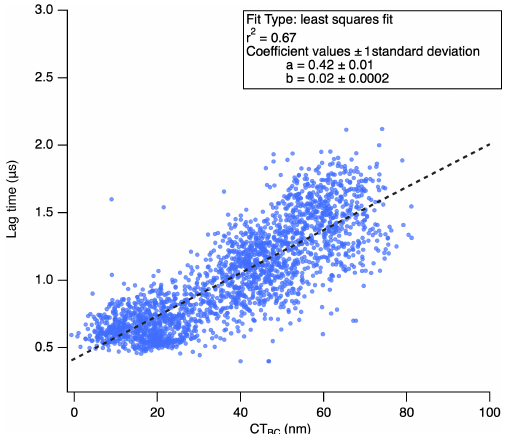
Figure 9. Scatterplot as a function of lag time (i.e., delay time) and BC coating thickness (CT BC ). Each point on the plot repre- sents a 10min mean value. Data shown include average values from all three campaigns. A significant correlation is confirmed using a linear correlation test. The coefficient values a and b represent the y intercept and slope of the least squares fit,